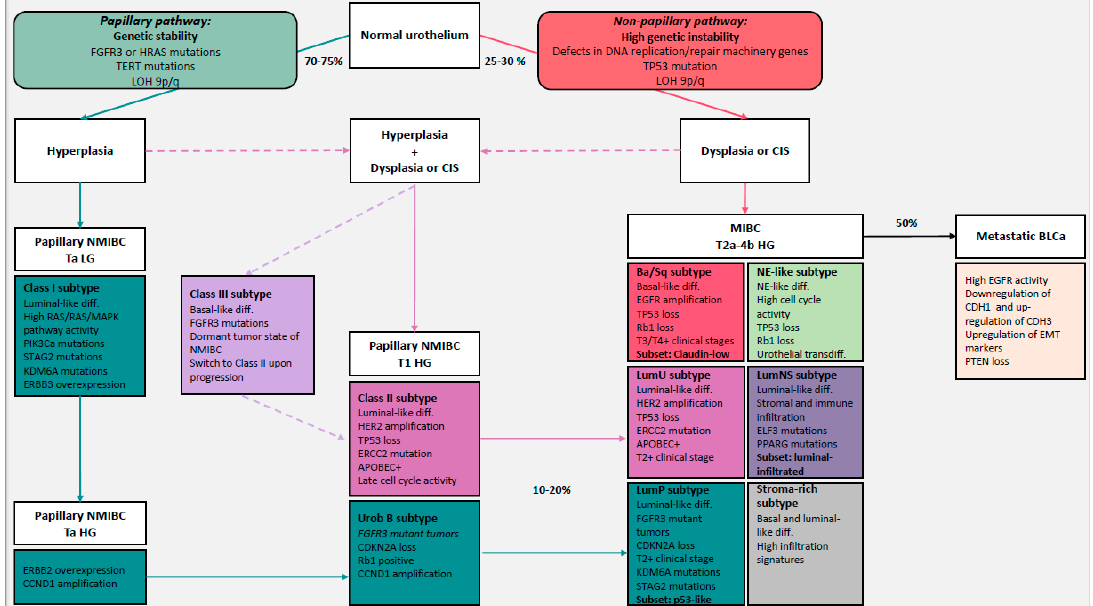
Figure 1. Simplified representation of the evolution of bladder cancer (BLCa) including the two distinct carcinogenic pathways (papillary and non-papillary pathways) and molecular subtypes of BLCa with their di ff erent characteristics. 75–80% of BLCa are non-muscle invasive bladder cancer (NMIBC) and 20–25% are muscle invasive bladder cancer (MIBC), of which 50% progress to metastatic BLCa. The papillary pathway includes hyperplasia which will give rise to Ta low-grade (LG) NMIBC and Ta / T1 high-grade (HG) NMIBC after the acquisition of mutations such as fibroblast growth factor receptor 3 (FGFR3) mutations or RAS mutations, loss of heterozygosity (LOH) 9p / q and telomerase reverse transcriptase (TERT) gene-promoter mutations. Class I / Urobasal A (Uro A) subtypes represent Ta LG NMIBC tumors and Uro B tumors were defined to be their progressed version. 10–20% of NMIBC potentially progress to MIBC and given the elevated expression of FGFR3 and the homozygous cyclin dependent kinase inhibitor 2A (CDKN2A) deletions in luminal papillary (LumP) tumors, they can originate from the progression of Class I / Uro A tumors through the papillary pathway. In the non-papillary pathway, instead, flat dysplasia and / or carcinoma in situ (CIS) are believed to be the precursors of MIBC tumors, after the gradual accumulation of genomic abnormalities such as loss of tumor suppressors TP53, defects in DNA replication / repair machinery genes (e.g., excision repair 2 (ERCC2)) and LOH 9q / p. Basal / Squamous (Ba / Sq) subtype represents the fraction of MIBC that